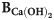
Effect of contact time on uptake of phenol on RH, BCa(OH)2, C400,1 and C400,4 (initial concentration, 100 mg.L-1; adsorbent dose, 10 g.L-1; pH 5.6; 23±1°C).